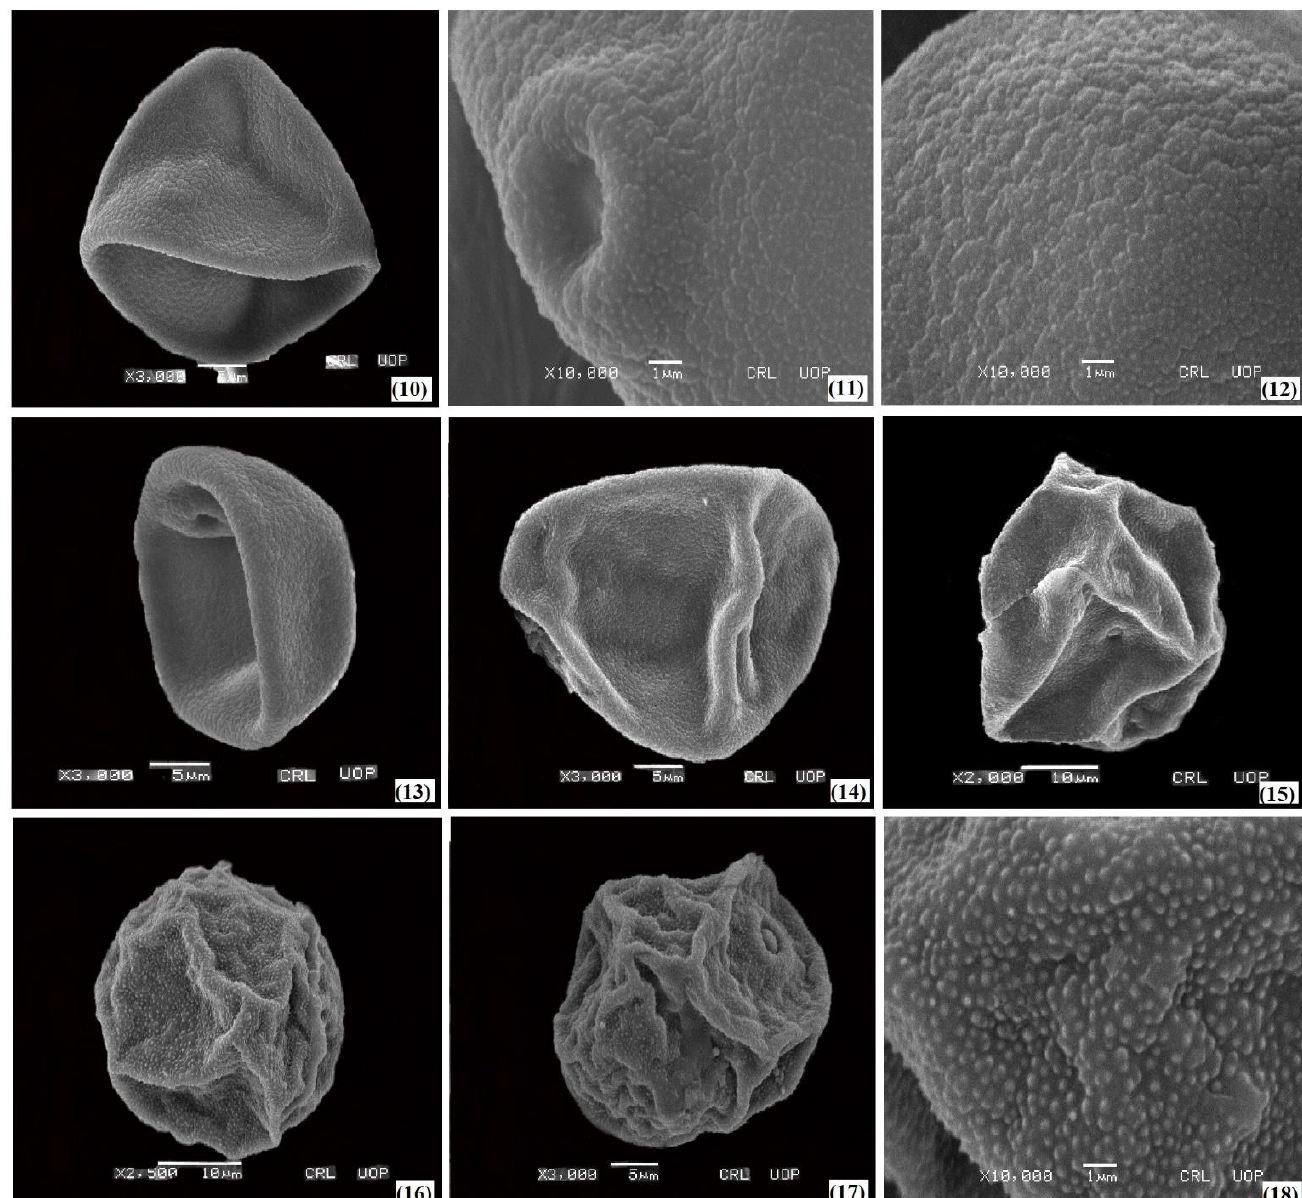
Figure 3. SEM pollen micrographs of salt tolerant grasses. Cenchrus ciliaris (10, 11, 12 & 13), Cenchrus pennisetiformis (14 & 15), Cymbopogon jwarancusa (16, 17 & 18).